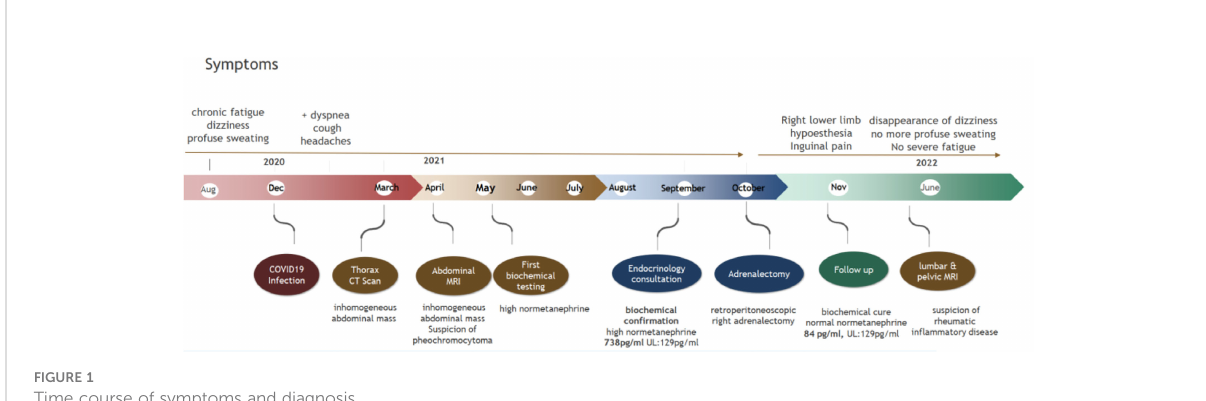
FIGURE 1 Time course of symptoms and